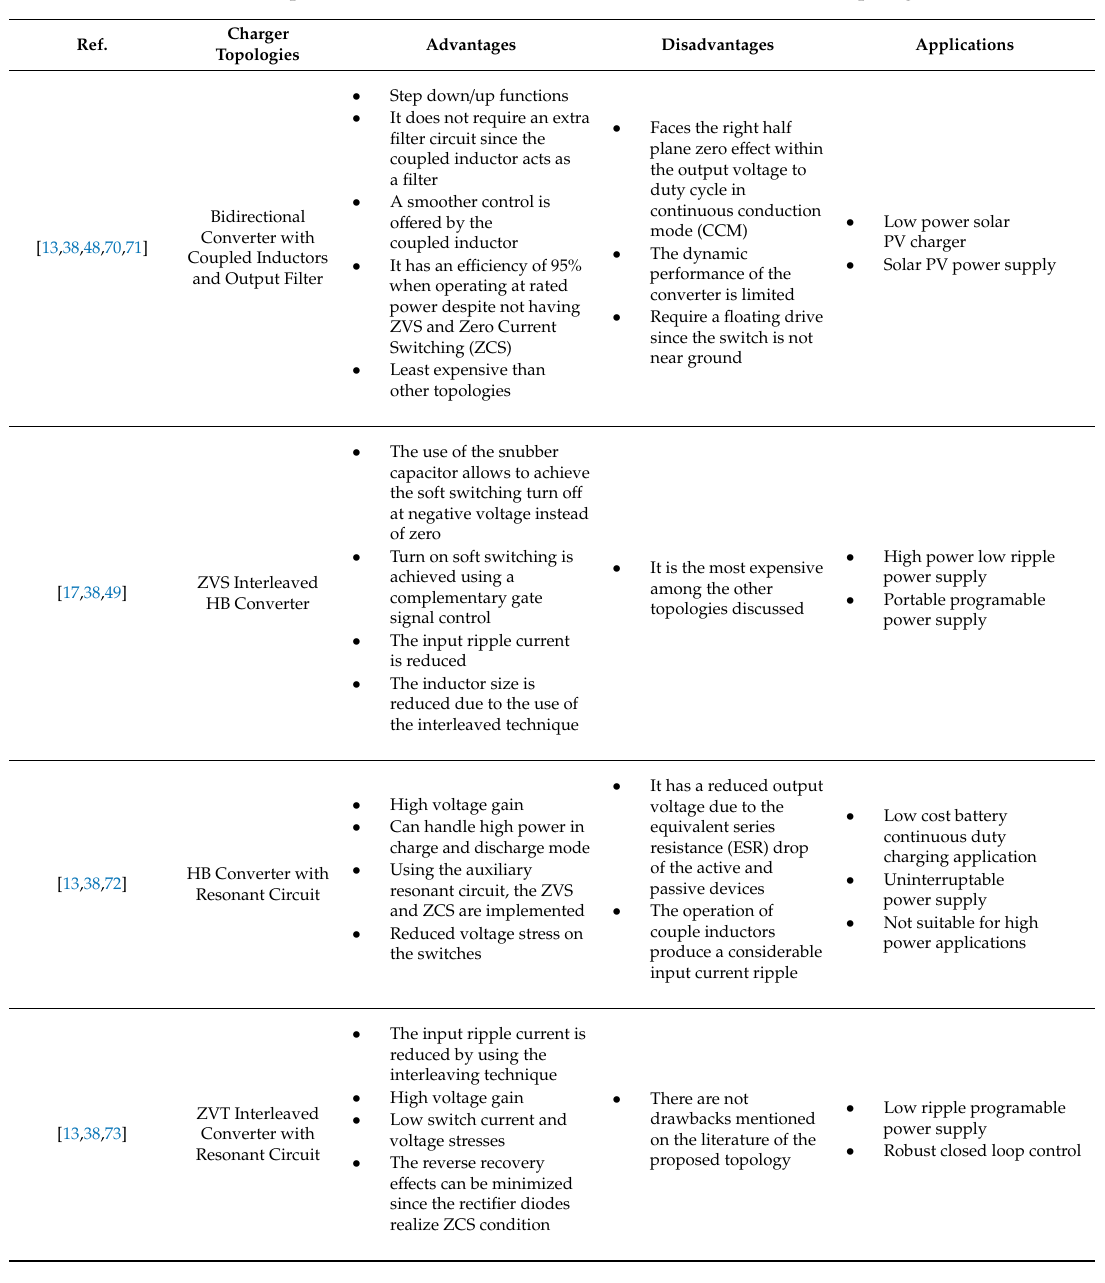
Figure 8. Schematic diagram of non-isolated bidirectional DC–DC converters. ( a ) Bidirectional converter with coupled inductors and output filter; ( b ) zero-voltage-switching (ZVS) interleaved HB converter; ( c ) HB converter with resonant circuit; ( d ) zero-voltage-transition (ZVT) interleaved converter with resonant circuit; ( e ) ZVS HB converter with coupled inductors; ( f ) three-phase interleaved buck converter [13,34,48,49,70–75].